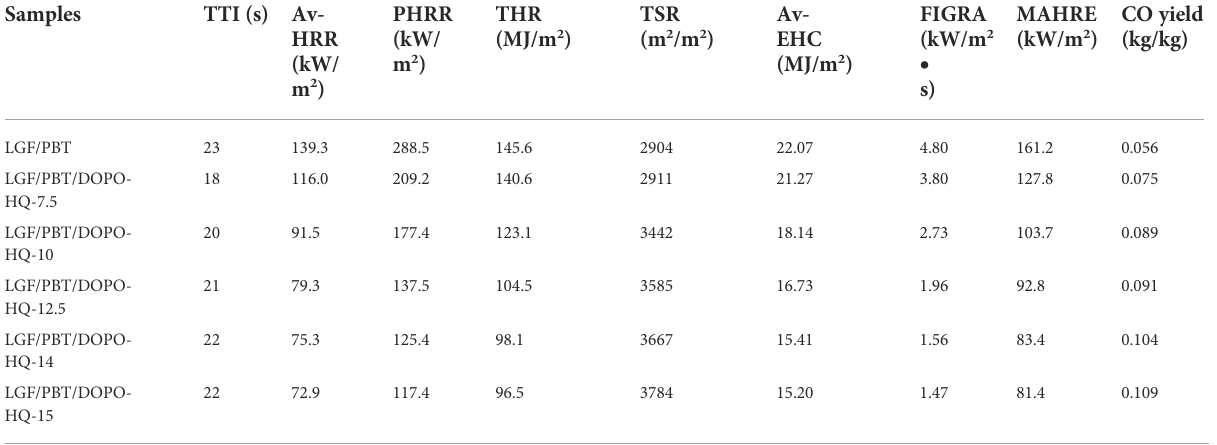
TABLE 2 The combustion results of LGF/PBT/DOPO-HQ composites obtained from CONE.